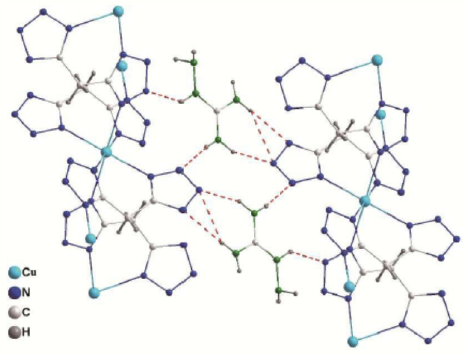
Figure 6. Extensive hydrogen bonding in the structure of {[AG] 2 (Cu(btm) 2 )]} n [49]. The aminoguanidinium nitrogen atoms are shown in green. Red dashed lines represent hydrogen.